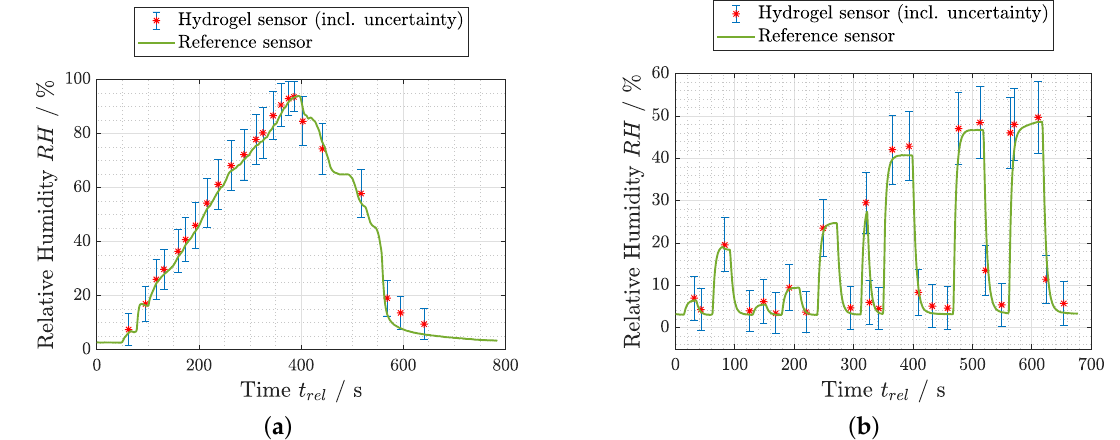
Figure 6. Evaluation measurements of the hydrogel sensor compared to the reference sensor for